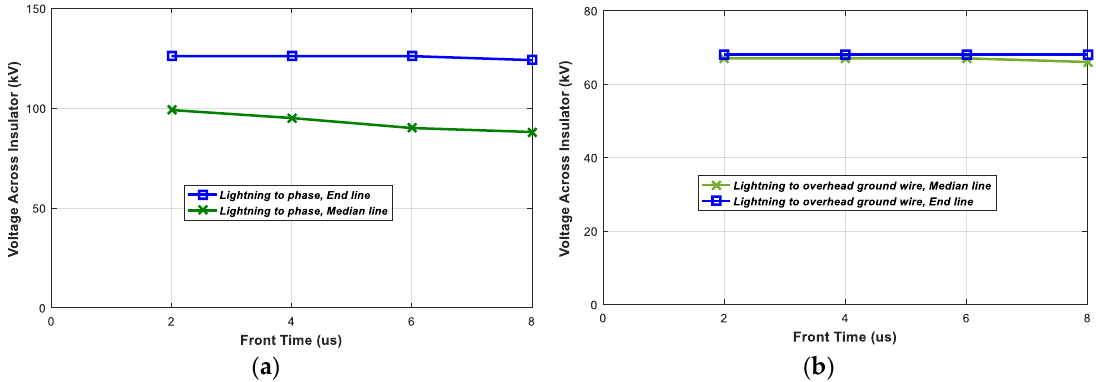
Figure 16. Voltage across the insulator for different front time lightning current wave shapes (grounding distance of overhead ground wire = 200 m, ground resistance = 10 Ω, tail time = 77.5 μs); ( a ) Strike to the phase conductor; ( b ) Strike to the overhead ground wire.